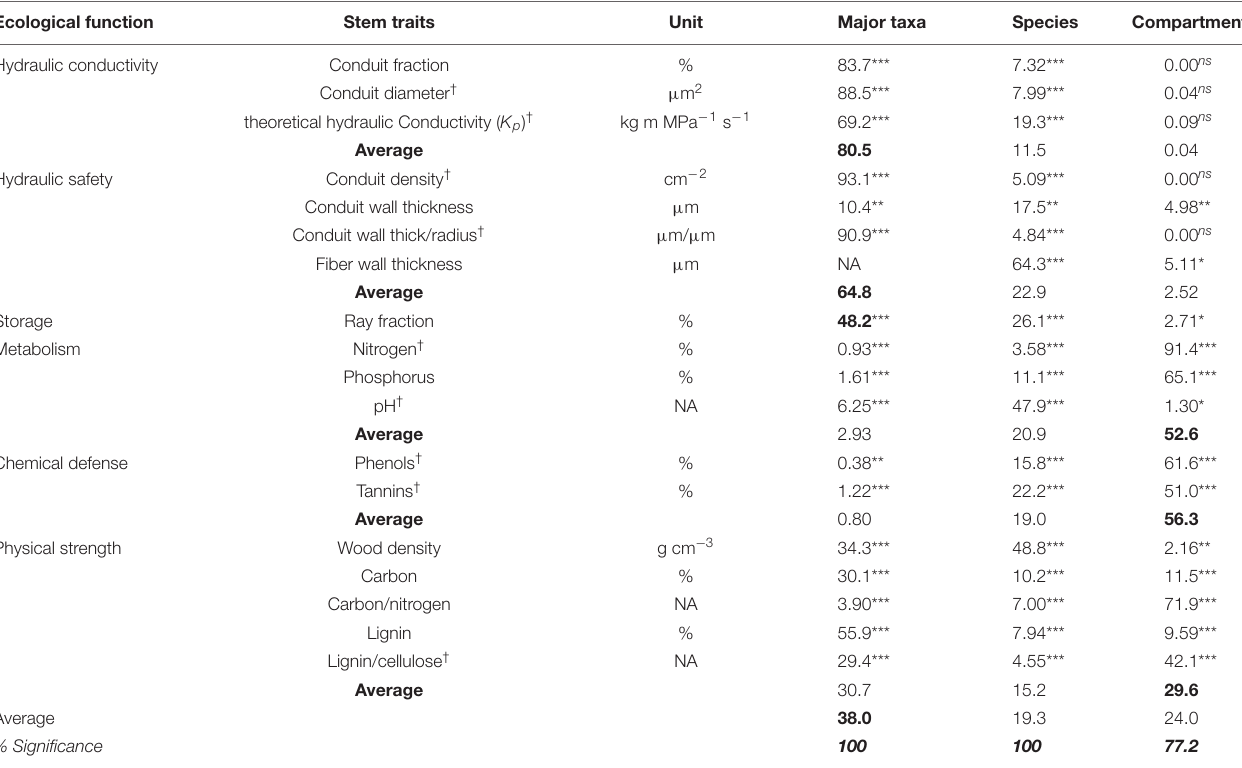
TABLE 2 | The percentage of trait variation explained by major taxa (angiosperms vs. gymnosperms), species within major taxa, and compartments (inner wood, outer wood, and bark). Ecological function Stem